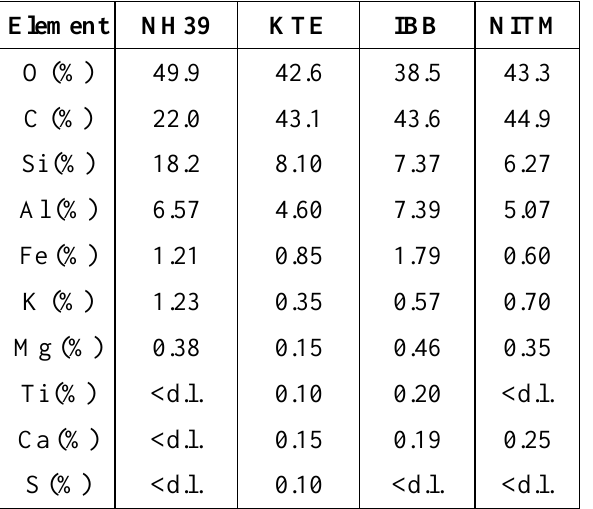
Table 6. Elemental composition (% weight) of Northeast Indian peats. <d.l. = below detection limit.